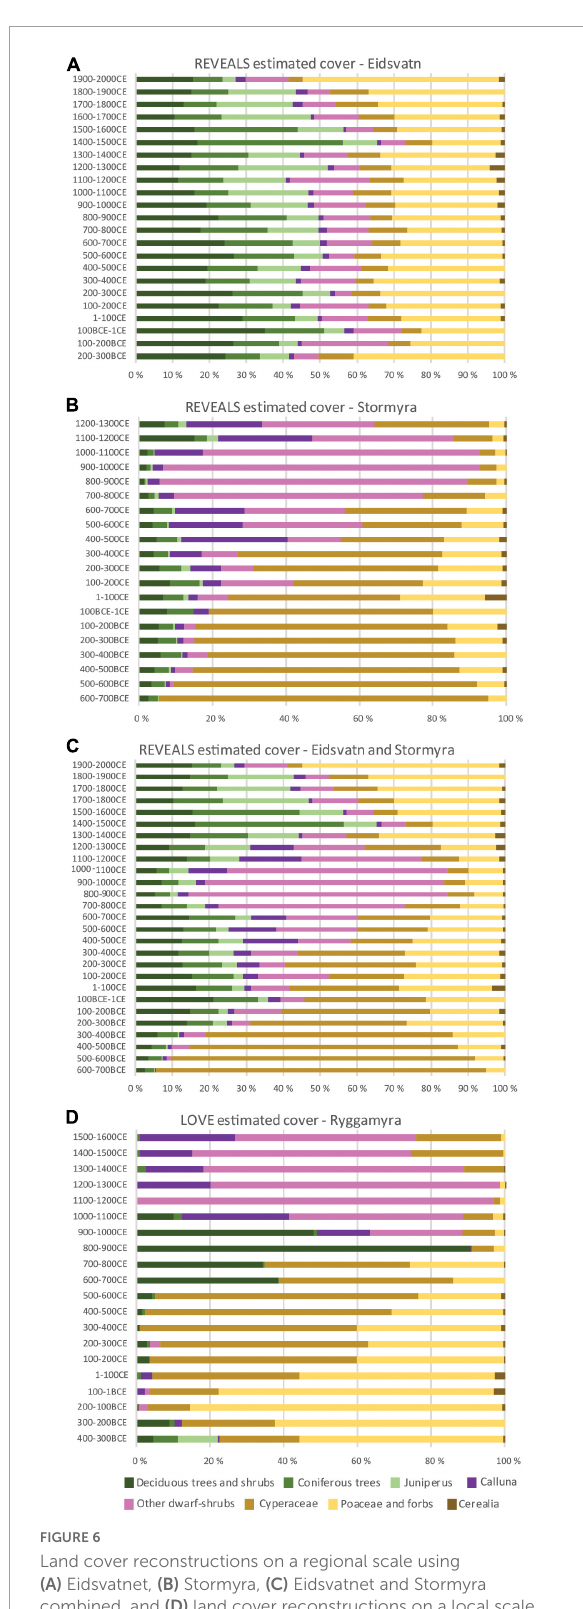
FIGURE6 Land cover reconstructions on a regional scale using (A) Eidsvatnet, (B) Stormyra, (C) Eidsvatnet and Stormyra combined, and (D) land cover reconstructions on a local scale. For original pollen data, see Supplementary Figures 2–4